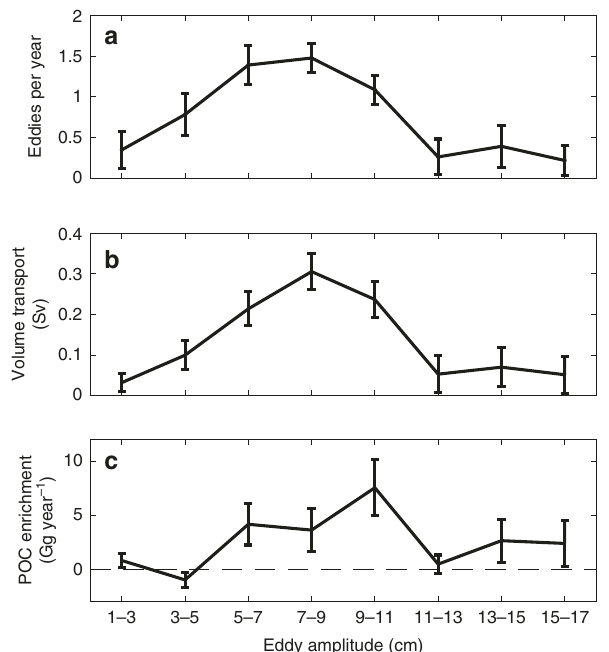
Fig. 5 Monthly particulate organic carbon anomaly. Mean particulate organic carbon anomaly (mg m − 3 ) and standard error within one eddy radius as a function of the month of the eddy occurrence for cyclonic eddies a formed and located inshore of 300 km, b formed inshore of 300 km and propagated to 300 – 600 km offshore, and c formed and located offshore between 300 and 600 km